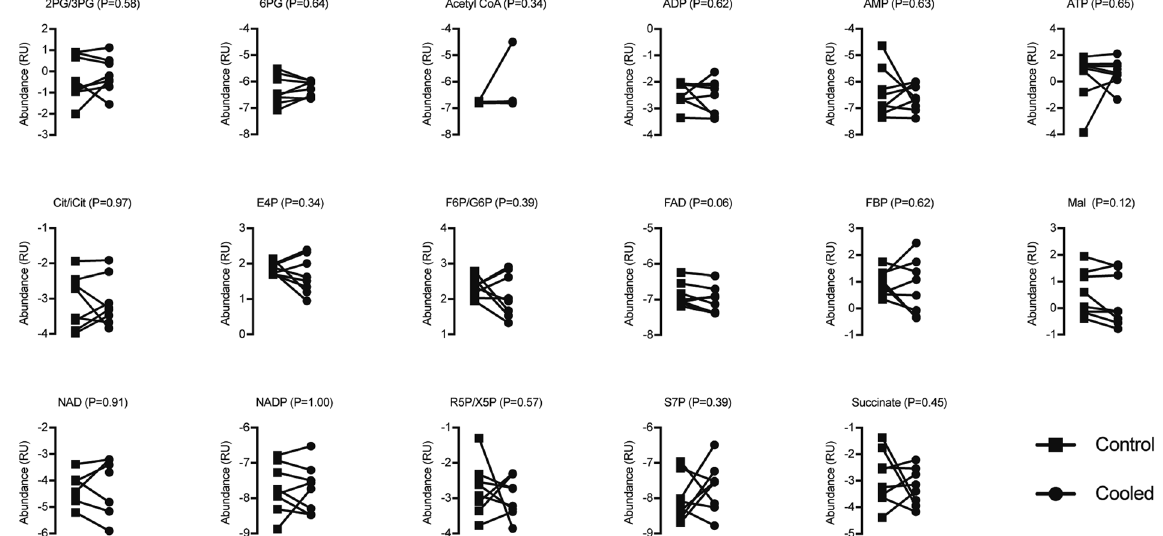
Figure 3. Metabolites with available isotopic standards. Relative abundance of 17 analytes measured in control and cooled muscles. Data were log 2 transformed prior to analysis. Differences were tested using paired t-tests, and p-values are indicated in each panel. N = 8